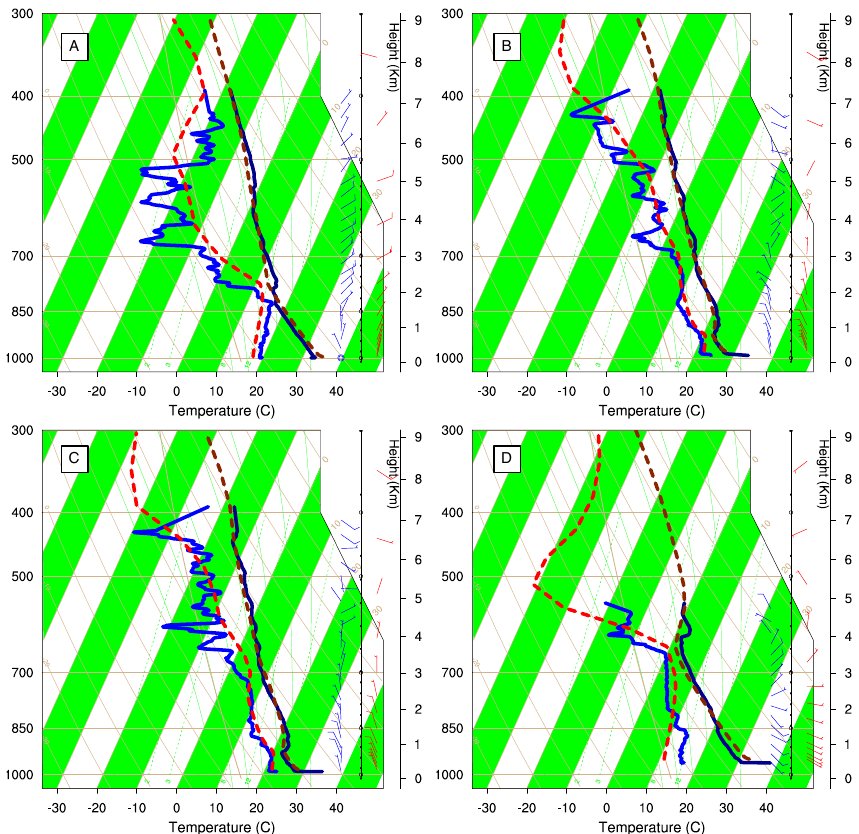
Figure 4. Skew-T plots comparing data from sondes dropped during SAMBBA flights with column data extracted from the WRF-Chem model at the time and place of the drop-sonde. Drop-sondes were taken from (a) B731 (14 September, dropped at 16:02:28UTC); (b) 734 (18 September, 12:46:52UTC); (c) B734 (18 September, 12:56:53UTC); and (d) B742 (27 September, 13:36:59UTC). The red dashed lines are from WRF-Chem model data; the blue solid lines are from drop-sonde. The bright coloured lines on the left show dewpoint ( ◦ C); the dark coloured lines on the right show temperature ( ◦ C). The barbs on the right of the plots show wind direction from drop-sonde (blue) and model